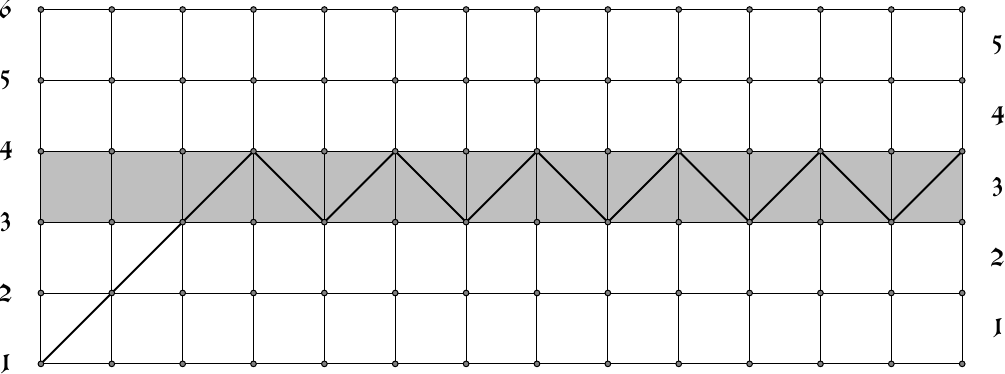
Figure 8 . The minimal path in the vacuum module of the restricted solid-on-solid model L 2 ; 7 , labeled by a = 1, b = 3, and c = 4. The weight of a minimal path is